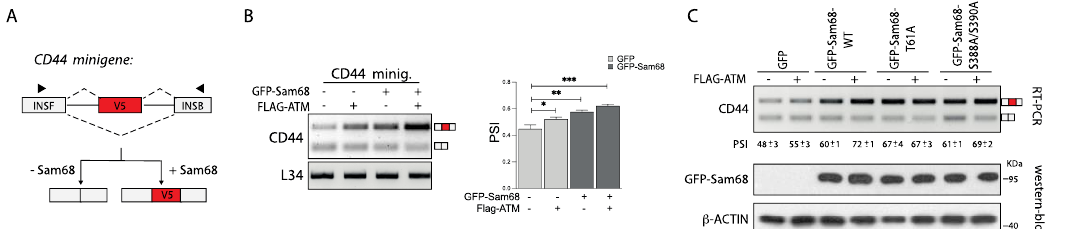
Figure 6. ATM-dependent phosphorylation modulates Sam68 splicing activity. ( A ) Schematic representation of CD44 minigene construct: v5 is the exon included in presence of Sam68 and black arrows indicate primers used for the RT-PCR analysis. ( B , C ) Representative PCR agarose gel of splicing assays of CD44 minigene performed in HEK293T cells transiently transfected with the indicated GFP-Sam68 plasmids and/or in addition to FLAG-ATM plasmid in presence of CD44 minigene ( B , C ). The percent spliced in (PSI) is reported in B and C (* p < 0.05, ** p < 0.01, *** p < 0.001, t test). L34 hasbeen used as a loading control ( B ). Western blot analysis to evaluate GFP-Sam68 proteins expression is also shown. β -actin was used as loading control ( C ).